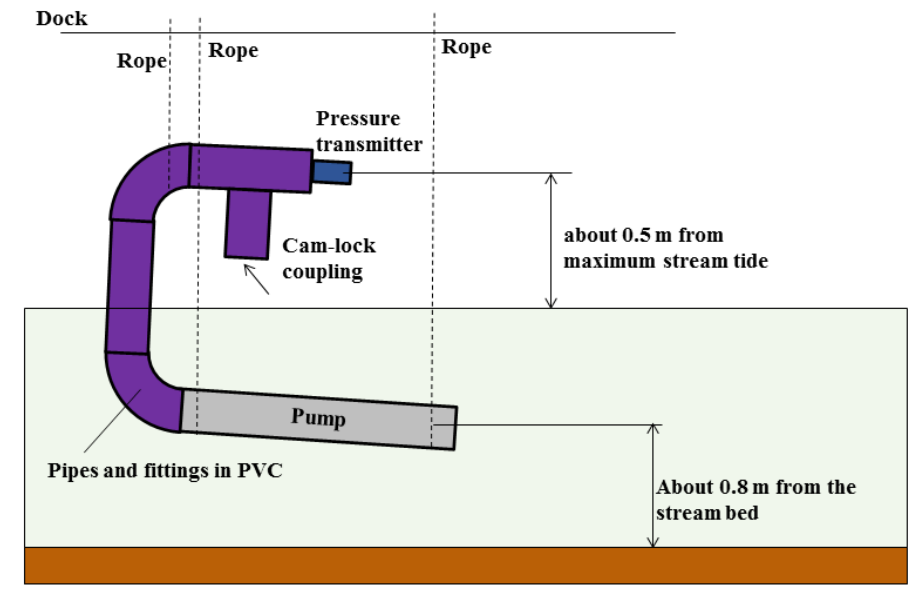
Figure 5. Schematic of pump installation.